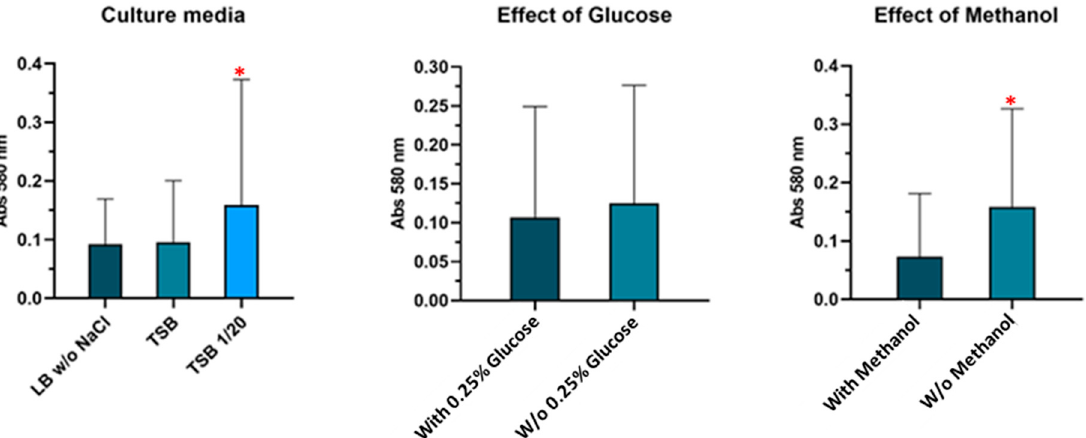
Figure 2. Conditions tested for the induction of biofilm formation in Salmonella spp. using the three strains under study. Data shown are mean values of three replicates and standard deviations. Red asterisks (*) indicate significant differences ( p < 0.05) between conditions.